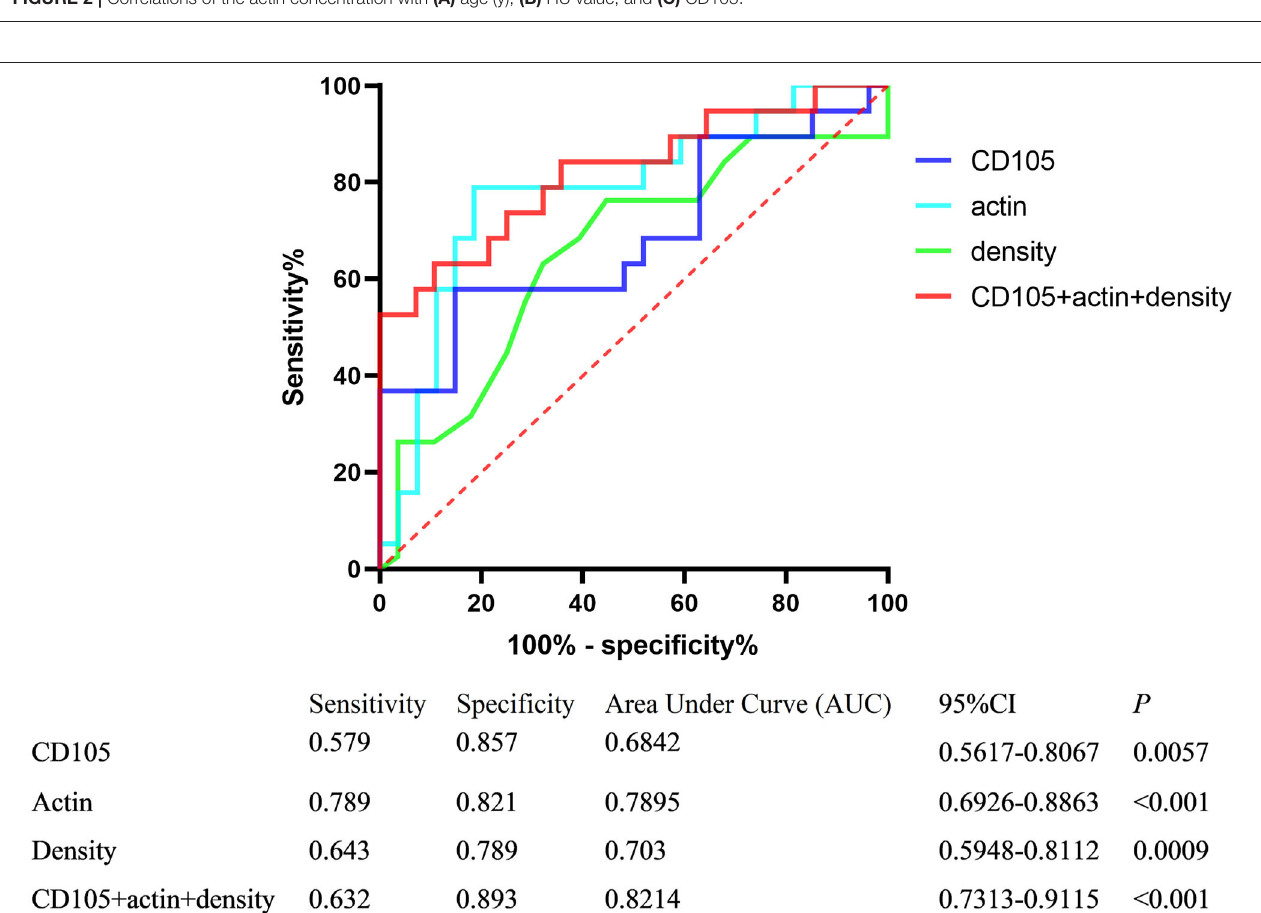
FIGURE 3 | Receiver operator characteristic (ROC) curves of variables differentiating stroke